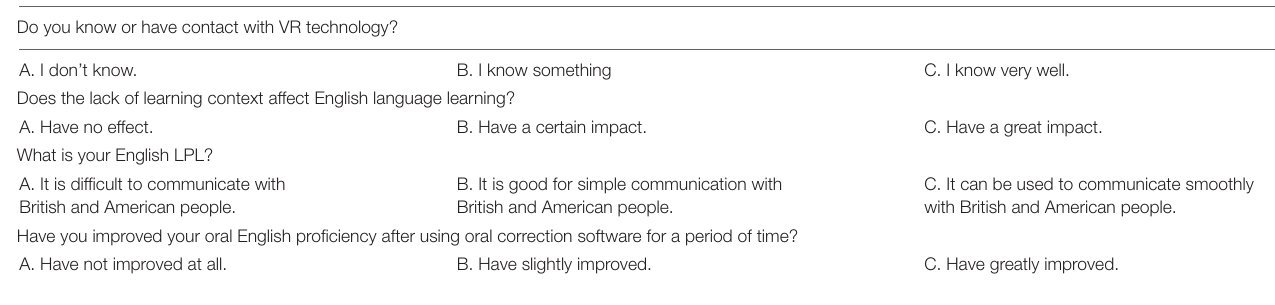
TABLE 1 | A QS on the effectiveness of VR technology in English language learning. Do you know or have contact with VR